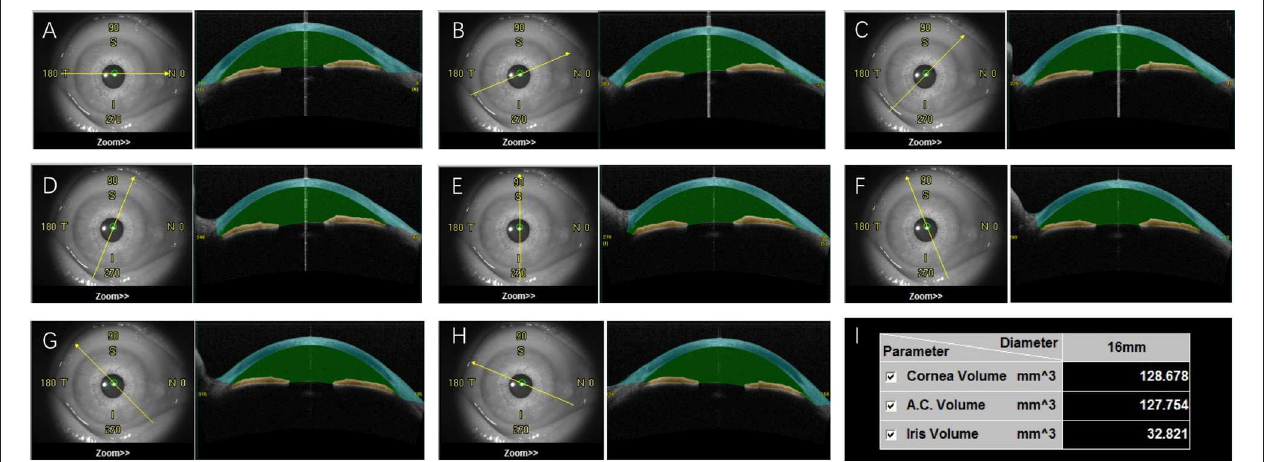
FIGURE 1 | The anterior chamber volume (ACV) automatically calculated by OCT. After the scanning, OCT images were divided into eight sections with different orientations (A–H) . The space between cornea (blue) and iris (yellow) was defined as anterior chamber (green). The volume of cornea, anterior chamber and iris were then automatically calculated (I) .